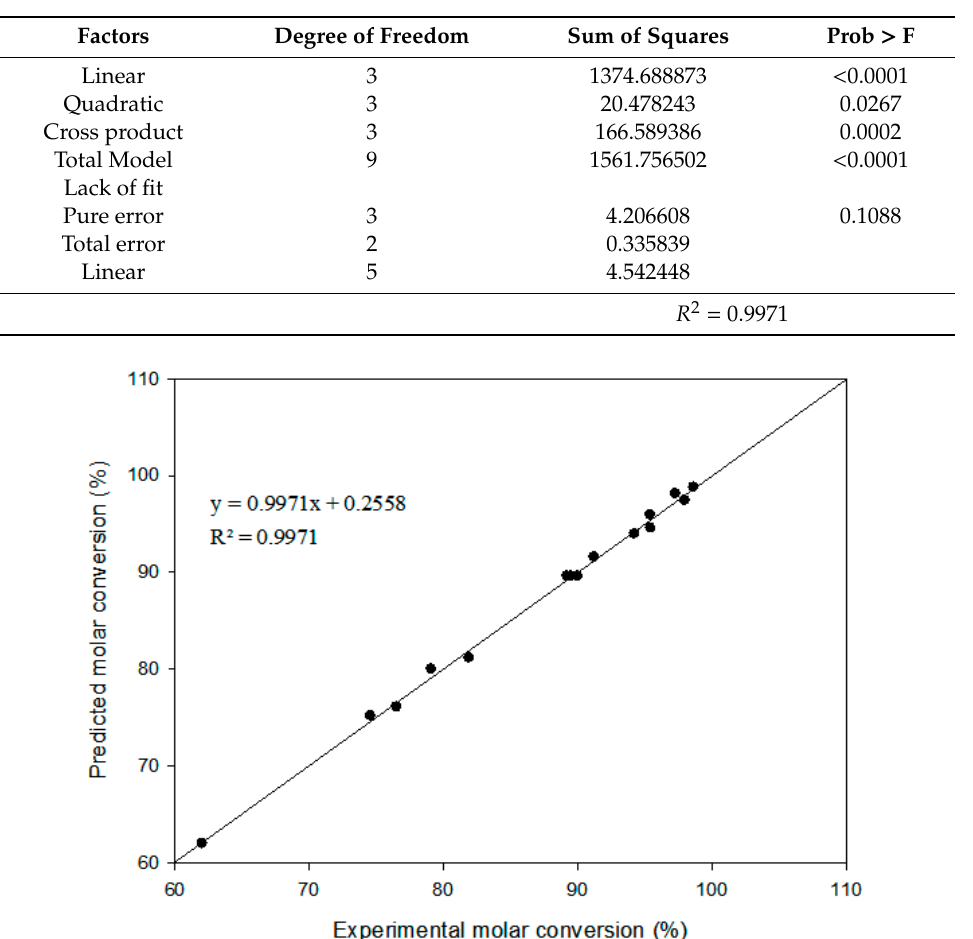
Table 2. Analysis of variance (ANOVA) analysis for continuous lipase-catalyzed 2-PEAc synthesis.